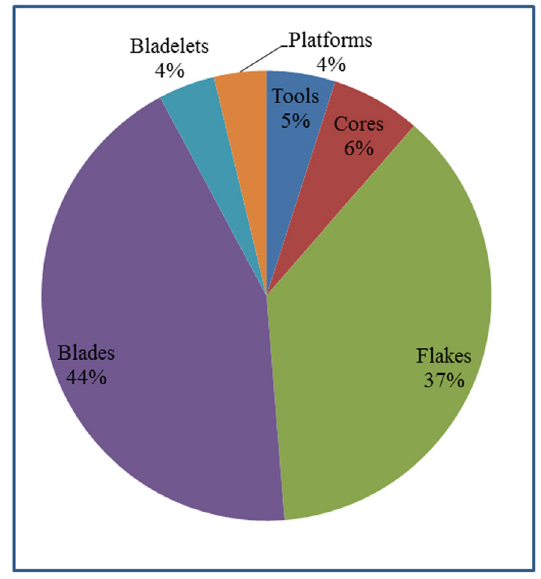
Figure 4. Lipari, Contrada Diana trench XVII. Histogram 2: quantity of artifacts reaching the third stage of knapping.